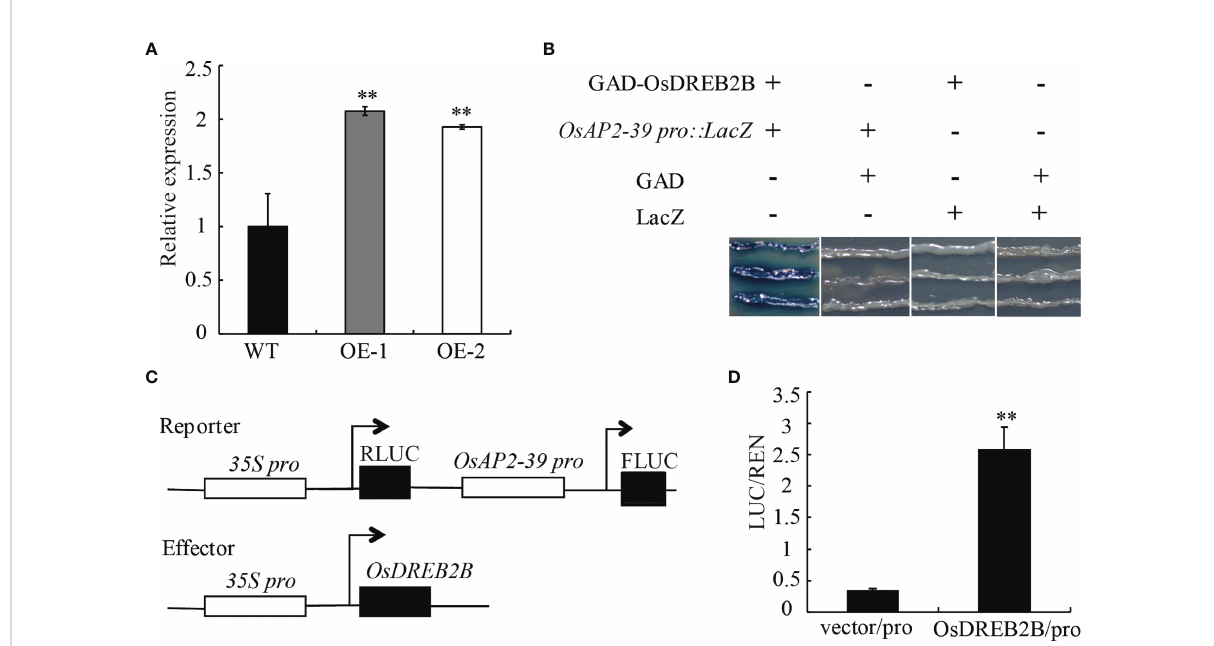
FIGURE 8 Direct regulation of OsAP2-39 by OsDREB2B. (A) Relative expression of the OsAP2-39 gene in the WT and OE lines. (B) Combination of OsDREB2B and OsAP2-39 in yeast. GAD-OsDREB2B activates the expression of LacZ reporter genes driven by OsAP2-39 promoters in yeast. GAD, GAL4 transcriptional activation domain. (C) Schematic diagram of the carrier in the dual luciferase reporter system. (D) In vivo dual luciferase reporter assay. Flag-OsDREB2B and OsAP2-39pro : FLUC , Flag, and OsAP2-39pro : FLUC were co-transformed into rice protoplasts and incubated at 28°C for 12 – 14 (h) FLuc and RLuc activities were measured, and Renilla luciferase (RLuc) was used as an internal control. Student ’ s t-tests were used to generate the P values. **Signi fi cant differences between the WT and OE plants at P =